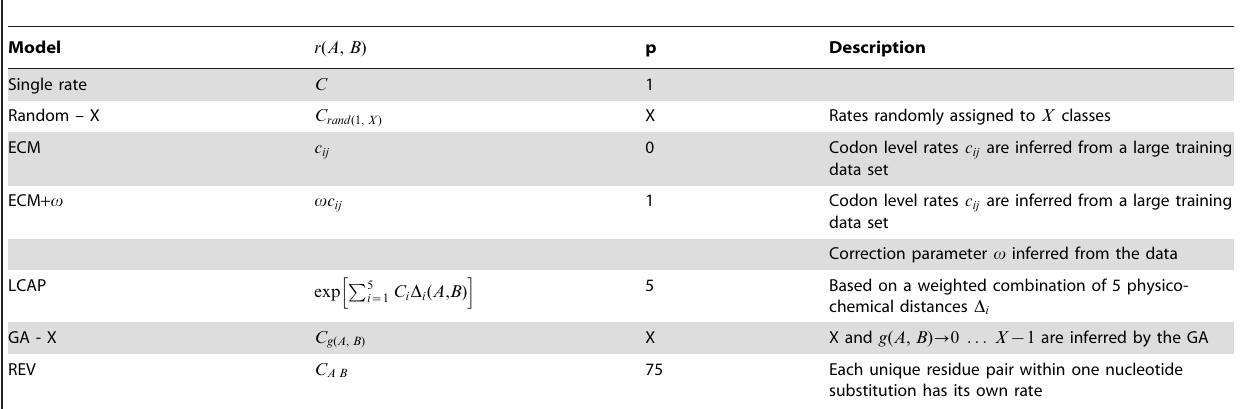
Table 1. Various approaches to estimating residue-dependent non-synonymous substitution rates.